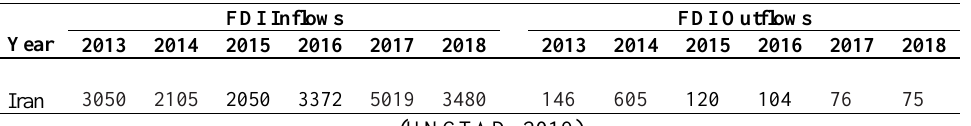
Table 1. Iran FDI flows 2011–2018 (Millions of